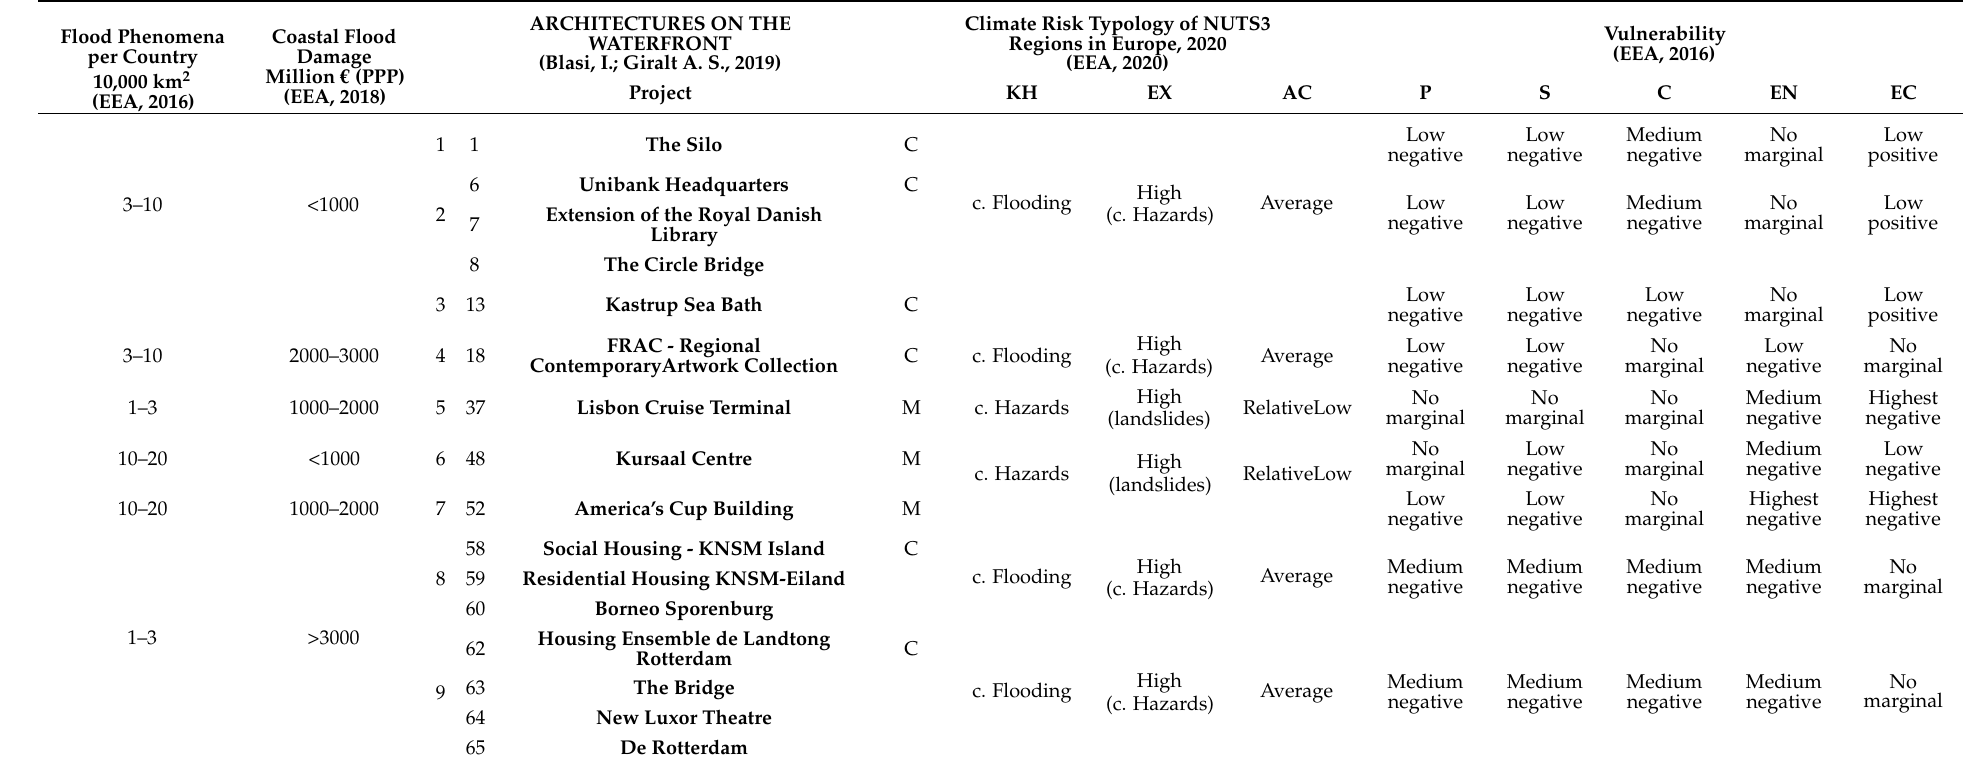
Table 5. Waterfront public space decode. Authors’s Edition. Source Data: